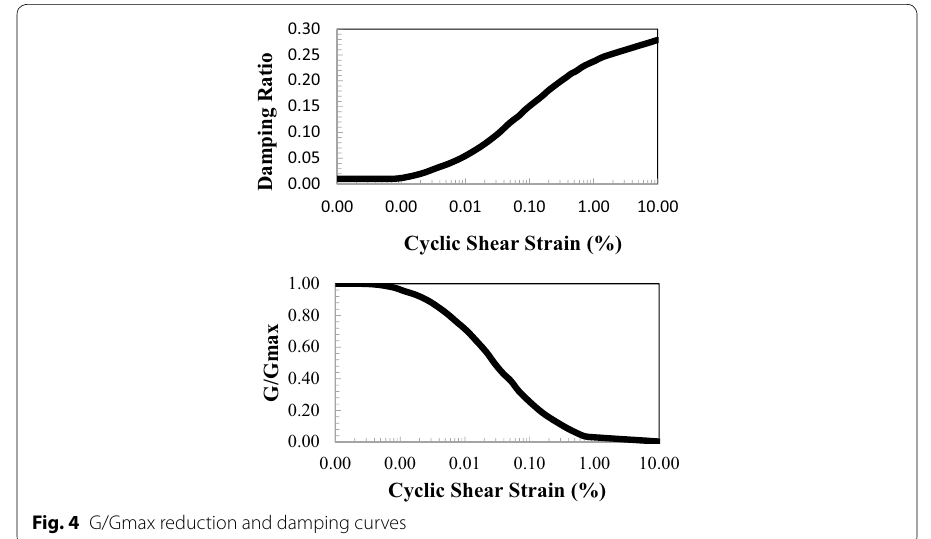
Fig. 4 G/Gmax reduction and damping curves